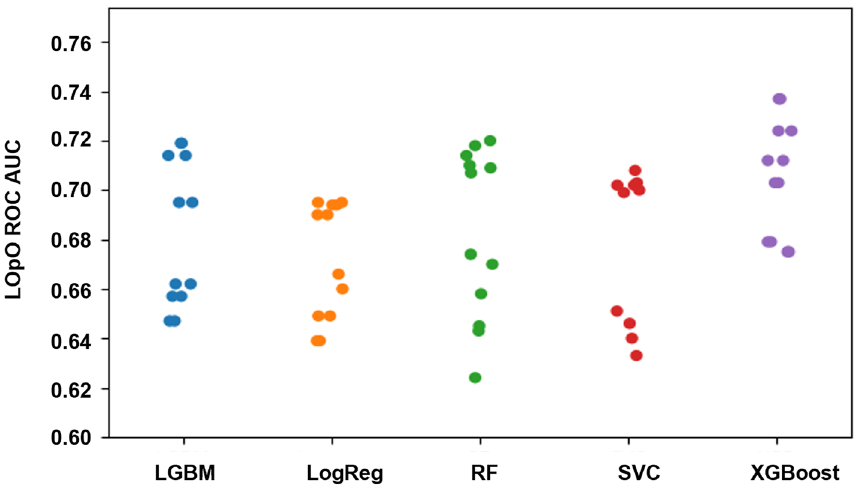
Figure 2. Selection of the ML model. The model performance was estimated by Leave-one-patient-out cross- validation (LOpO CV) on the training set of the Sheba Medical Center cohort, comparing of the ROC AUC of 5 different ML models. Each dot stands for (1) a specific ML model, as marked on the abscissa, (2) a specific prediction scope (48 h or 96 h), and (3) a specific choice of the set of dynamic features. The density and location of the cloud, formed by the aggregation of dots for each ML model indicate the model robustness and accuracy.